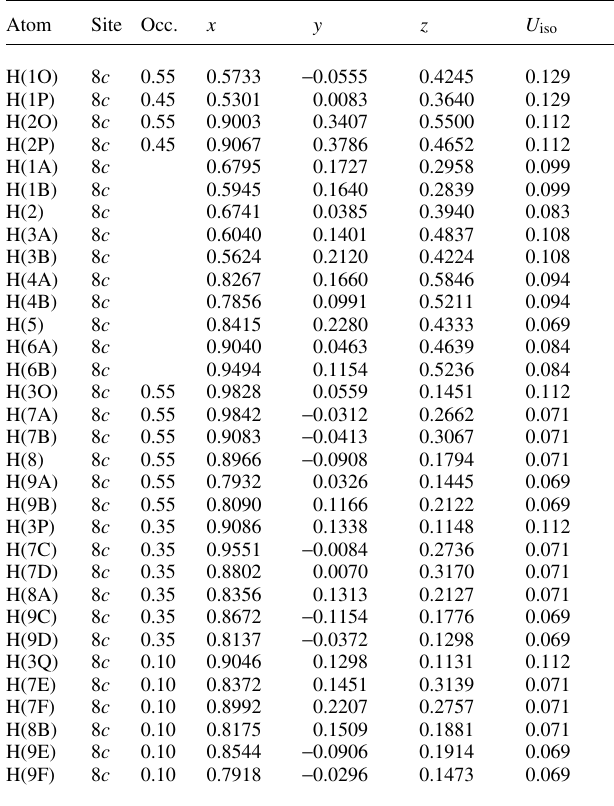
Table 2. Atomic coordinates and displacement parameters (in Å 2 ) .